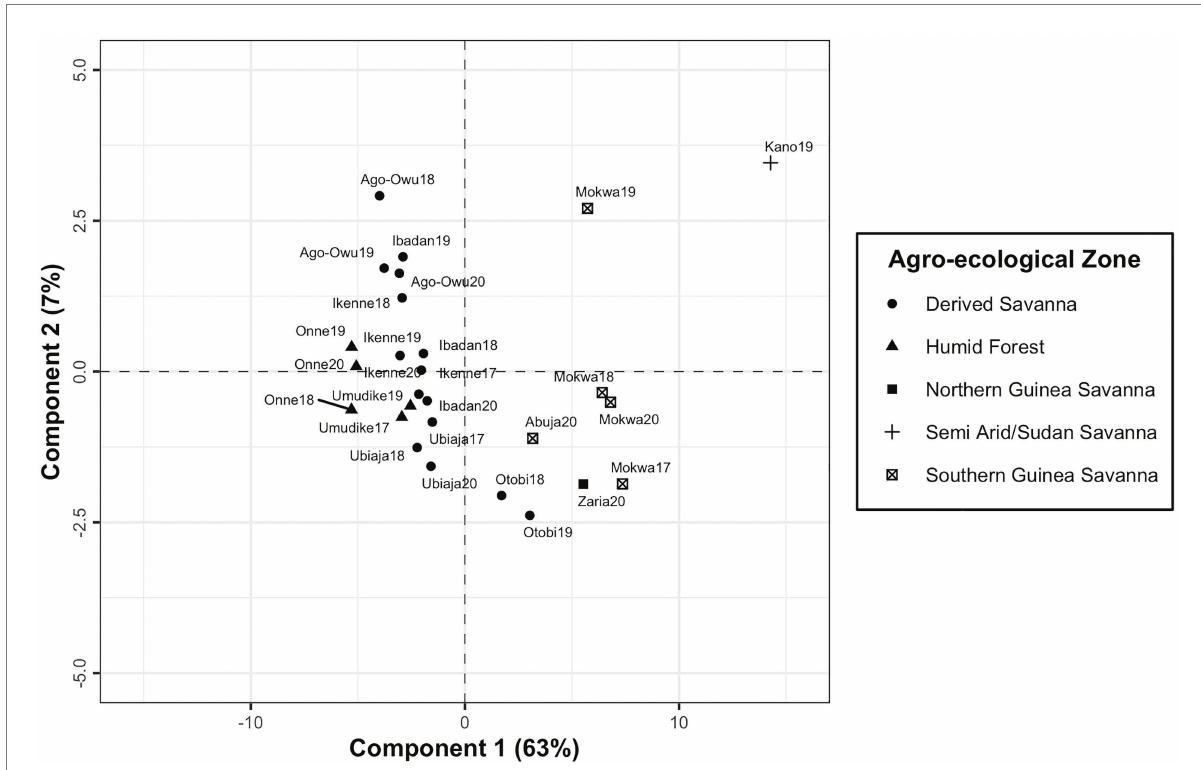
FIGURE 6 A plot of first and second components of X-scores revealing the grouping of the testing environments based on latent factor loadings from FA3 model and environmental